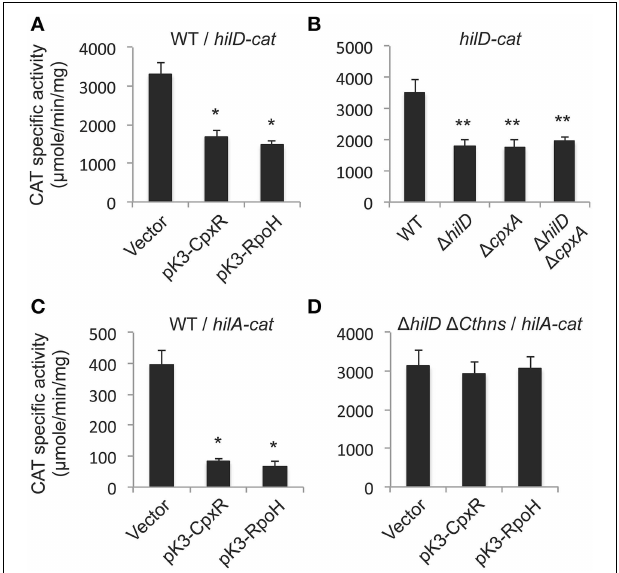
FIGURE 4 | CpxR represses the autoregulation of hilD and thus negatively affects the expression of hilA . Expression of the hilD-cat transcriptional fusion carried by plasmid philD-cat was tested in the WT S . Typhimurium strain carrying plasmid pK3-CpxR or pK3-RpoH, or the vector pMPM-K3 (A) , as well as in the WT S . Typhimurium strain and its isogenic 1 hilD , 1 cpxA , and 1 hilD 1 cpxA mutants (B) . Expression of the hilA-cat transcriptional fusion carried by plasmid philA-cat was tested in the WT S . Typhimurium strain (C) , or in its isogenic 1 hilD 1 Cthns mutant (D) , containing plasmid pK3-CpxR or pK3-RpoH, or the vector pMPM-K3. Plasmids pK3-CpxR and pK3-RpoH, as well as Salmonella , lack the gene encoding the repressor LacI and thus they constitutively express CpxR and RpoH, respectively, from a lac promoter. CAT-specific activity was determined from samples collected of bacterial cultures grown for 5h in LB medium at 37 ◦ C. The data are the averages of three different experiments performed in duplicate. Bars represent the standard deviations. *Expression statistically different with respect to that shown by the same fusion in the WT strain containing the vector. ** Expression statistically different with respect to that shown by the same fusion in the WT strain.